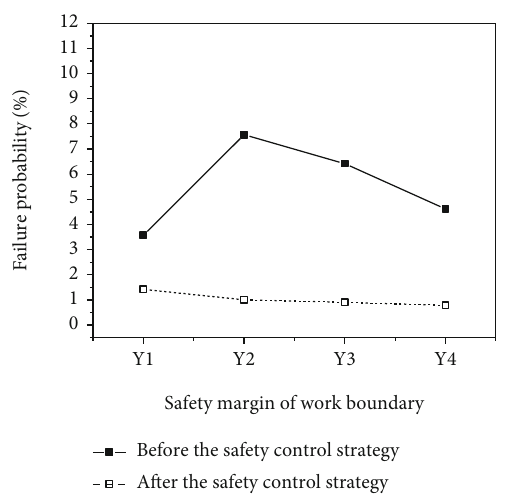
Figure 22: Comparison of the failure probability changes for each failure mode before and after the safety control strategy is